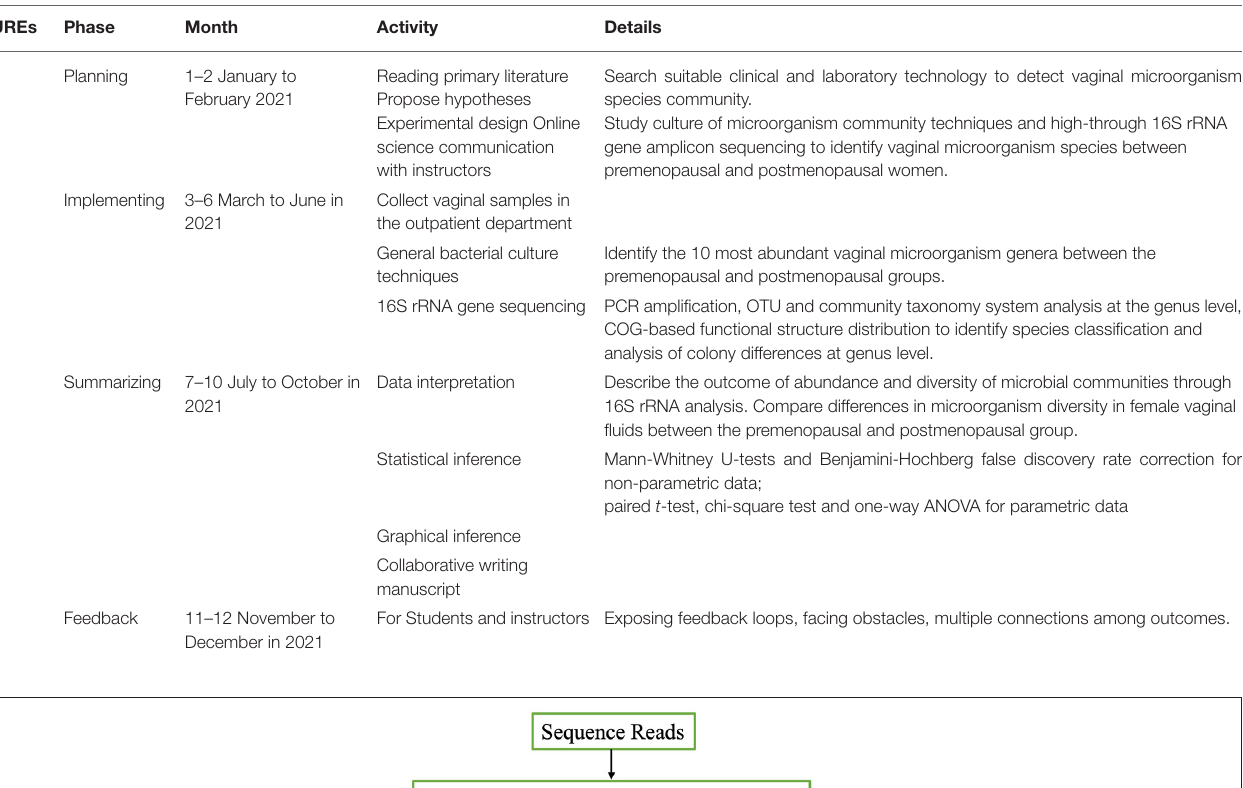
TABLE 1 | Stage goals, activities, and focal skills associated with each phase of the project.